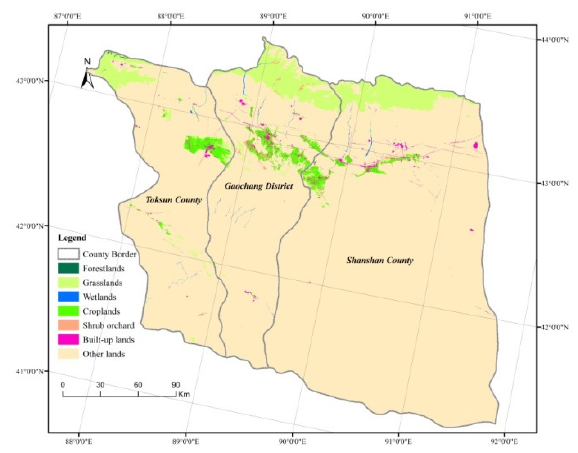
Figure 1. Location of Turpan, Gaochang District, Shanshan and Toksun Counties.